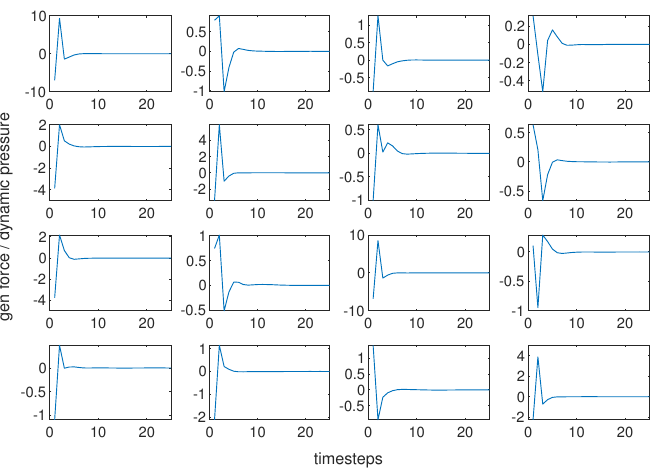
Figure 4. Sample aerodynamic impulse response matrix.